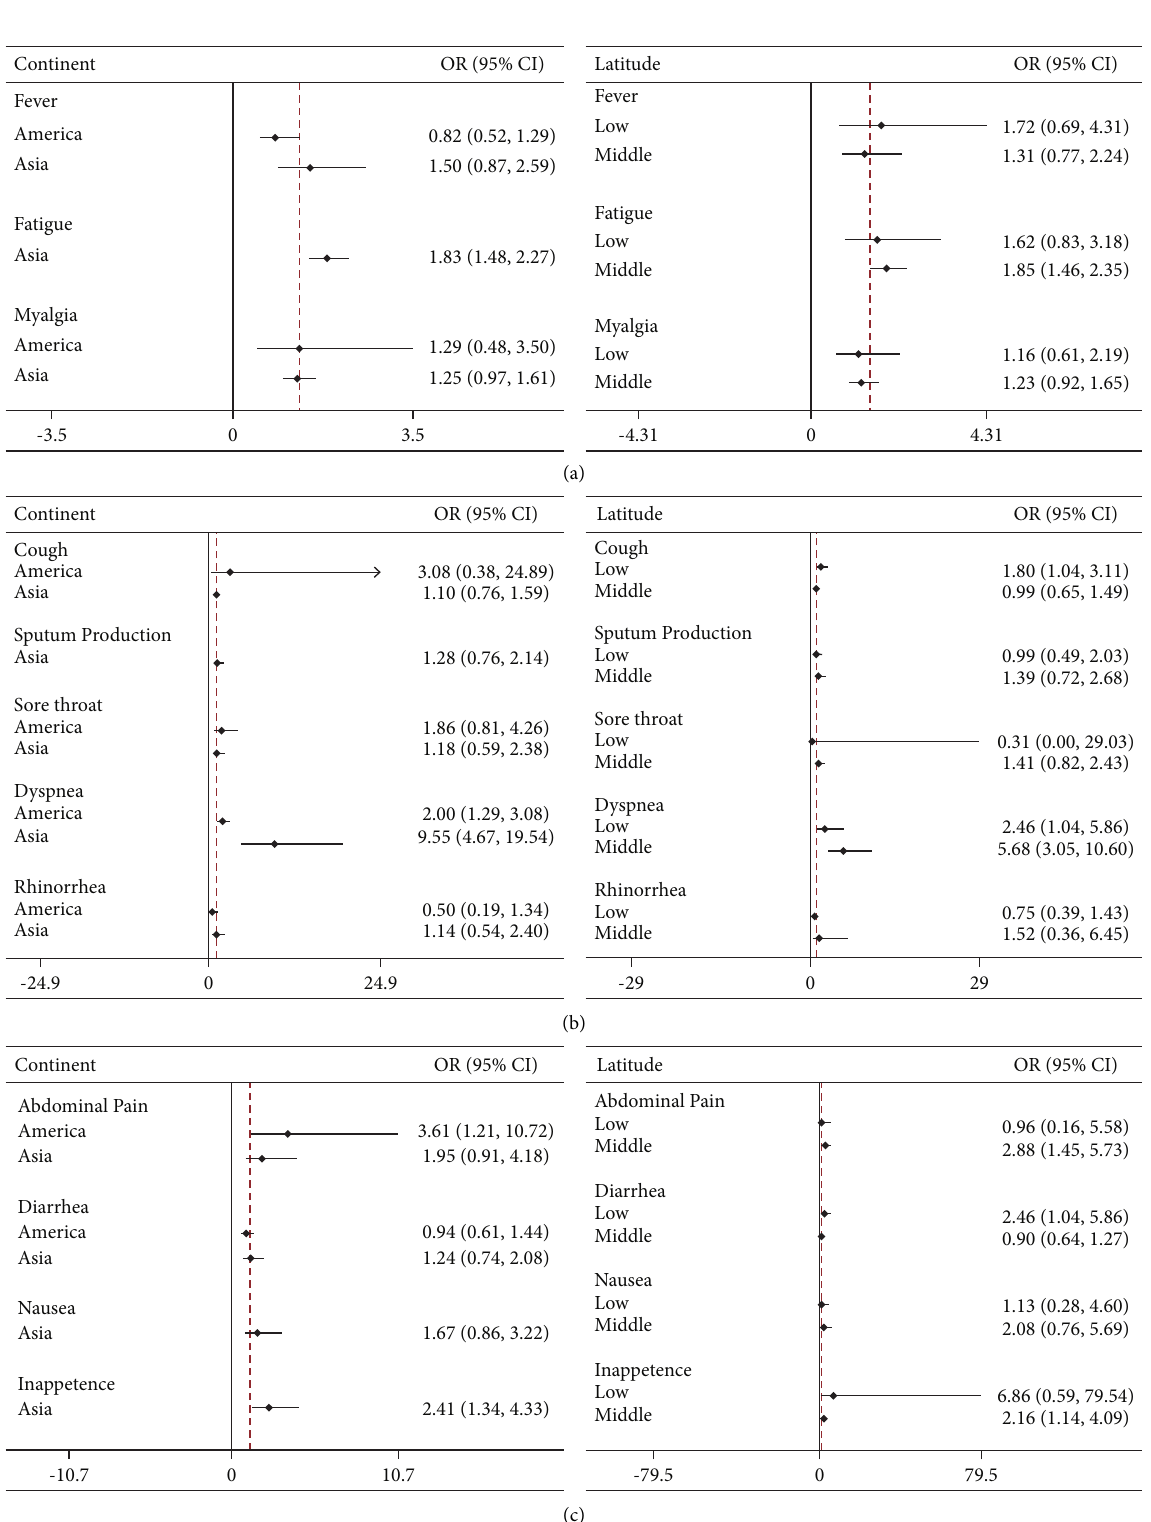
Figure 7: Comparison of the clinical manifestations of mild and severe COVID-19 patients in different